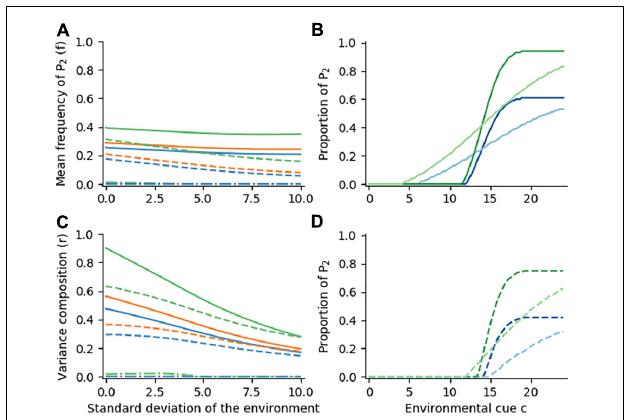
FIGURE 5 | Optimal reaction norm shapes for various growth rate functions and different levels of environmental predictability. Environments are normally distributed around a cue c with a mean of 14, but multiplied by 0.5. Panels, growth rates, coloring and line styles are the same as Figure 4